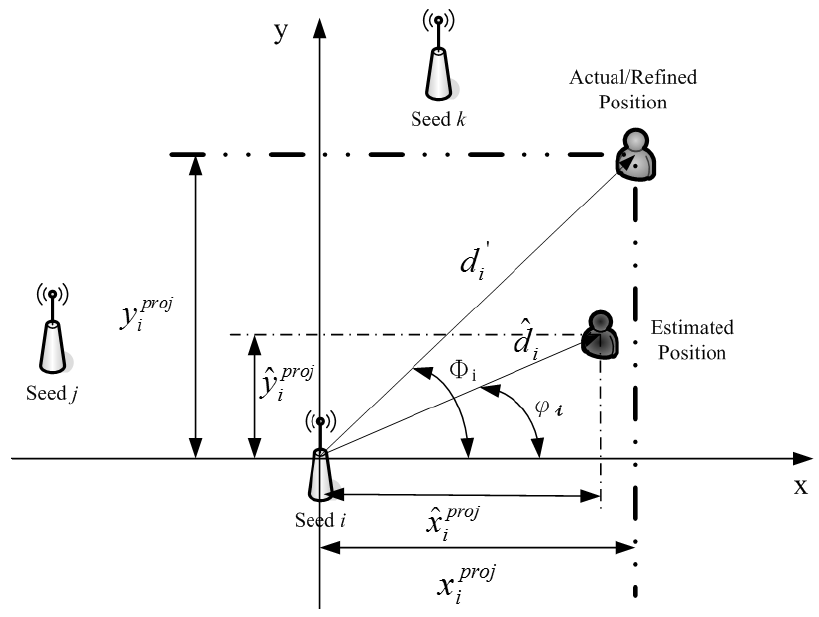
Figure 6. Estimation adjustment with AOA